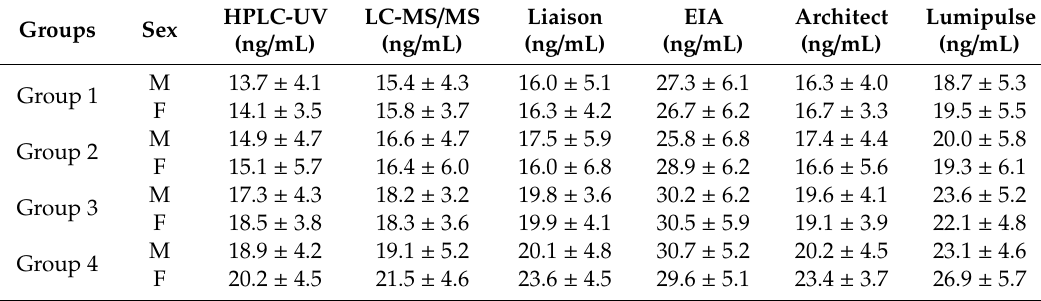
Table 2. Vitamin 25(OH)D evaluation in enrolled subjects (Groups 1, 2, 3, and 4) using high-performance liquid chromatography-ultraviolet (HPLC-UV), enzyme-linked immunosorbent assay (EIA), and chemiluminescence immunoassay (Liaison ® , Architect I1000 ® , and Lumipulse ® ) with respect to the gold standard liquid chromatography coupled with tandem mass spectrometry (LC-MS / MS). Data are expressed as mean ± standard